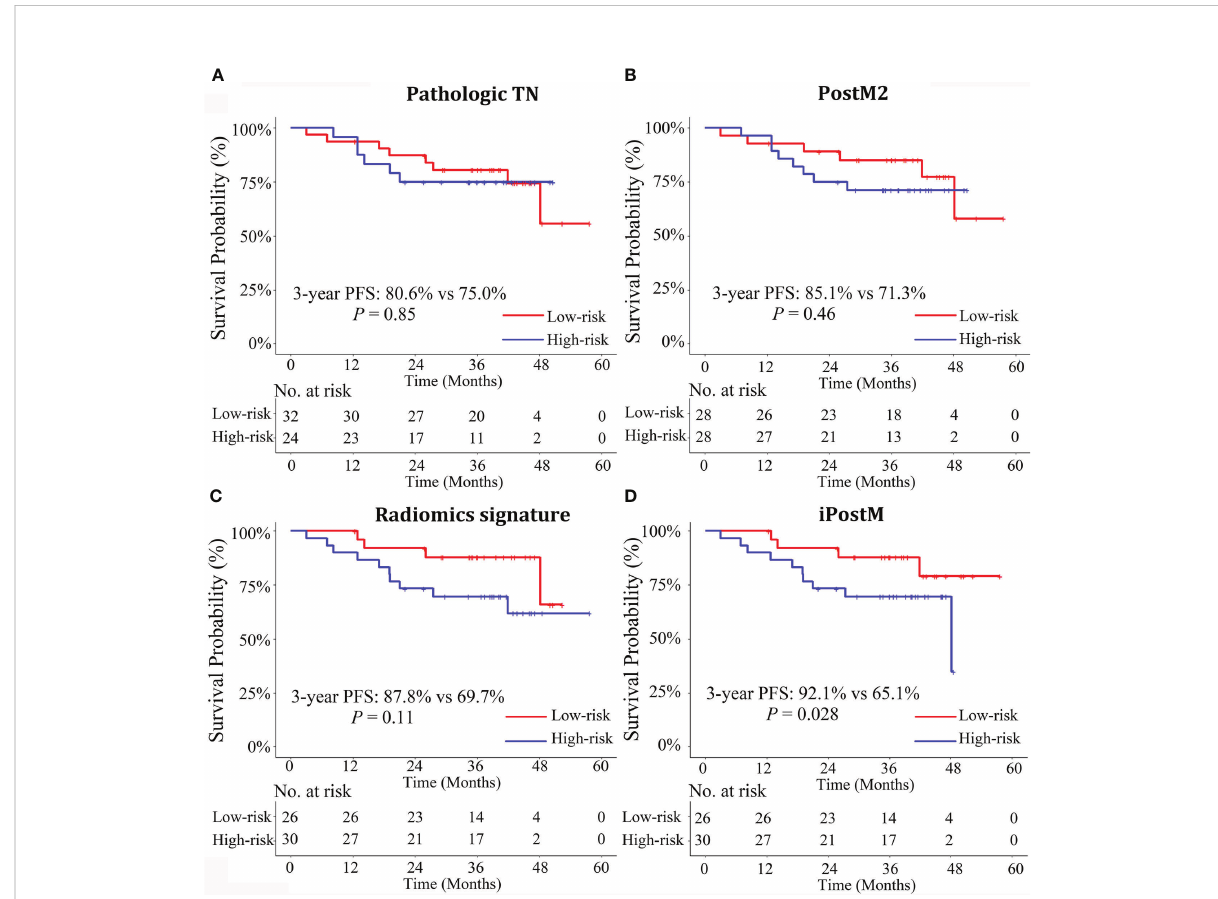
FIGURE 2 Strati fi ed Kaplan-Meier analyses of the prognostic models to estimate 3-year progression-free survival (PFS) in various risk strati fi cation subgroups in the validation cohort. Patients with high and low risks of PFS were strati fi ed by the prognostic models (A) Pathologic TN, (B) PostM2, (C) Radiomics signature, (D) iPostM models. Only the iPostM could stratify patients into high- and low-risk groups based on signi fi cantly different 3-year PFS rates (P < 0.05). The log-rank test was used to calculate P values. Pathologic TN, pathologic stage prognostic model; PostM2, post-treatment clinical prognostic model without pathologic stage; iPostM, integrated prognostic model combining tumor regression grade (TRG) and radiomic signature.